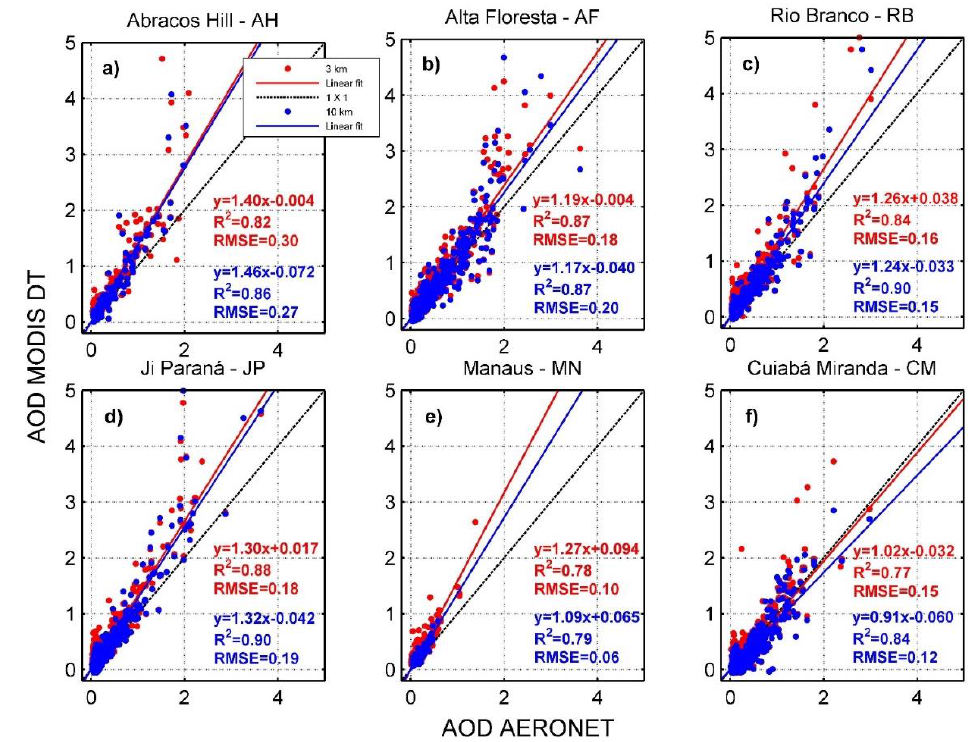
Figure 3. Linear regression models obtained between AOD from AERONET and from MODIS DT 3 km and 10 km (where the punctual measurements available on each site are represented): ( a ) Abracos Hill, ( b ) Alta Floresta, ( c ) Rio Branco, ( d ) Ji Paran á , ( e ) Manaus, and ( f ) Cuiab á Miranda. All models were statistically significant, with p -value < 0.001.